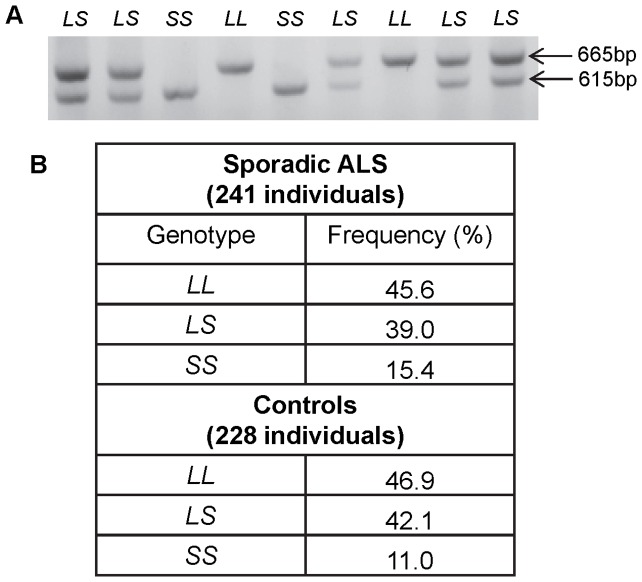
Genotype frequencies of SVA located upstream of the FUS gene in a SALS and matched control cohort.A- Example image of the two alleles of the TR/VNTR of the FUS SVA run on a 1.2% agarose gel after amplification using PCR. The two alleles identified were named long (L) and short (S) and the genotype of each individual was determined. One example of each allele was gel extracted and sequenced and corresponded to the previously sequenced and cloned alleles. L = 665 bp and S = 615 bp. B-. Table showing the percentage of each genotype in the SALS patients (241 individuals) and the matched controls (228 individuals).